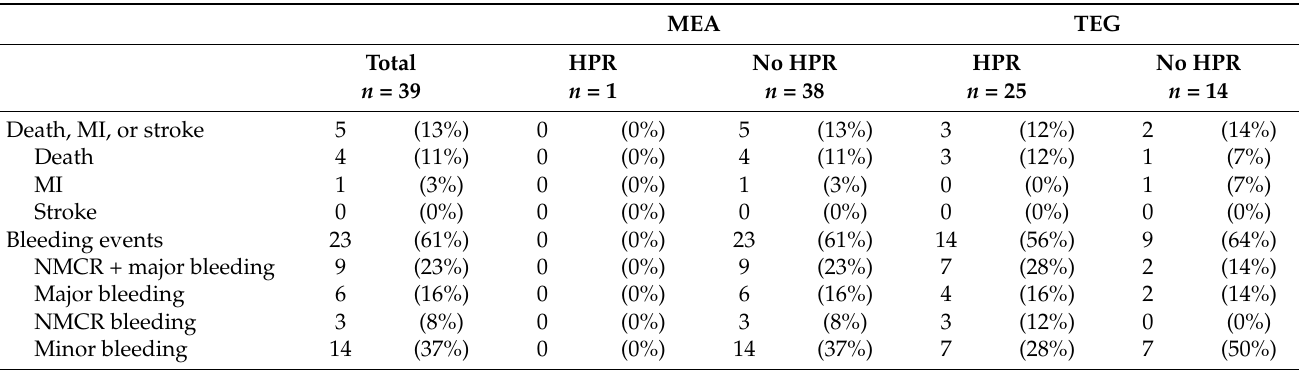
Table 3. Exploratory clinical outcomes at 6 months ± 2 weeks according to the presence of HPR and no HPR as assessed by MEA and